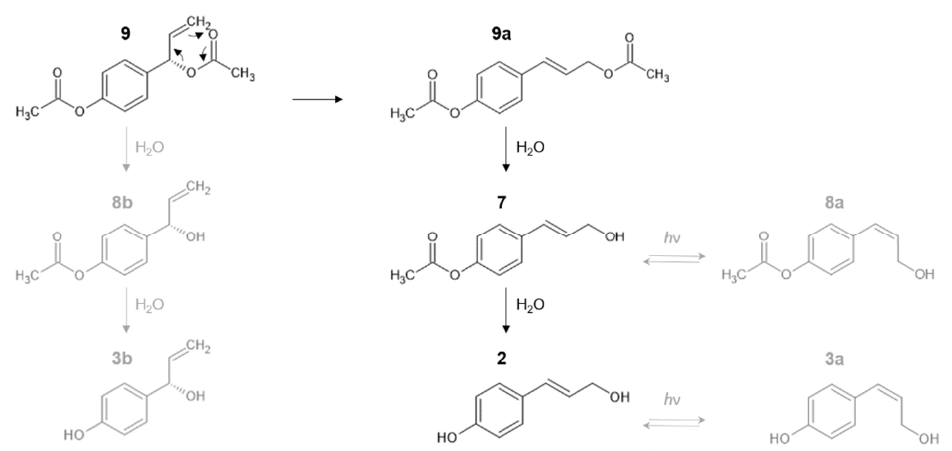
Figure 7. Decomposition of 1′ S -1′-acetoxychavicol acetate ( 9 ). Compound 9 probably undergoes sigmatropic rearrangement ( trans - p -coumaryl diacetate ( 9a )) and subsequent hydrolysis into trans - p -acetoxycinnamyl alcohol ( 7 ) intermediate, which is further hydrolysed to the trans - p -coumaryl-alcohol ( 2 ) degradation product. The assumed molecular structures for compound 3 and 8 are: cis-p -acetoxycinnamyl alcohol ( 8a ), (1′ S )-1′-hydroxychavicol acetate ( 8b ), cis-p- coumaryl-alcohol ( 3a ), and ( S )-4-(1-hydroxyallyl)phenol ( 3b ).